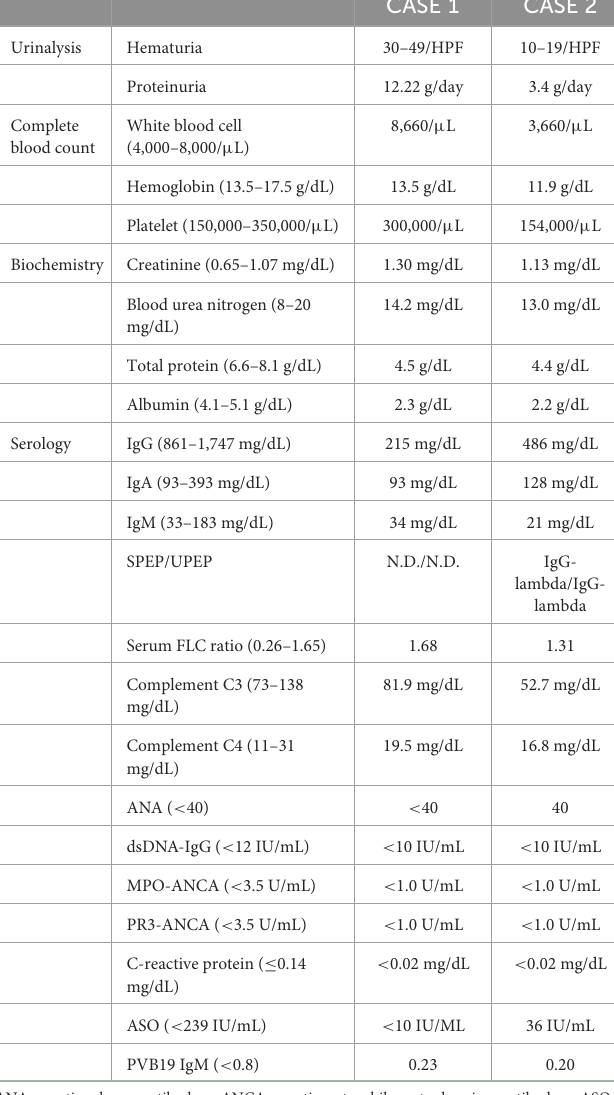
TABLE 1 Laboratory data of the